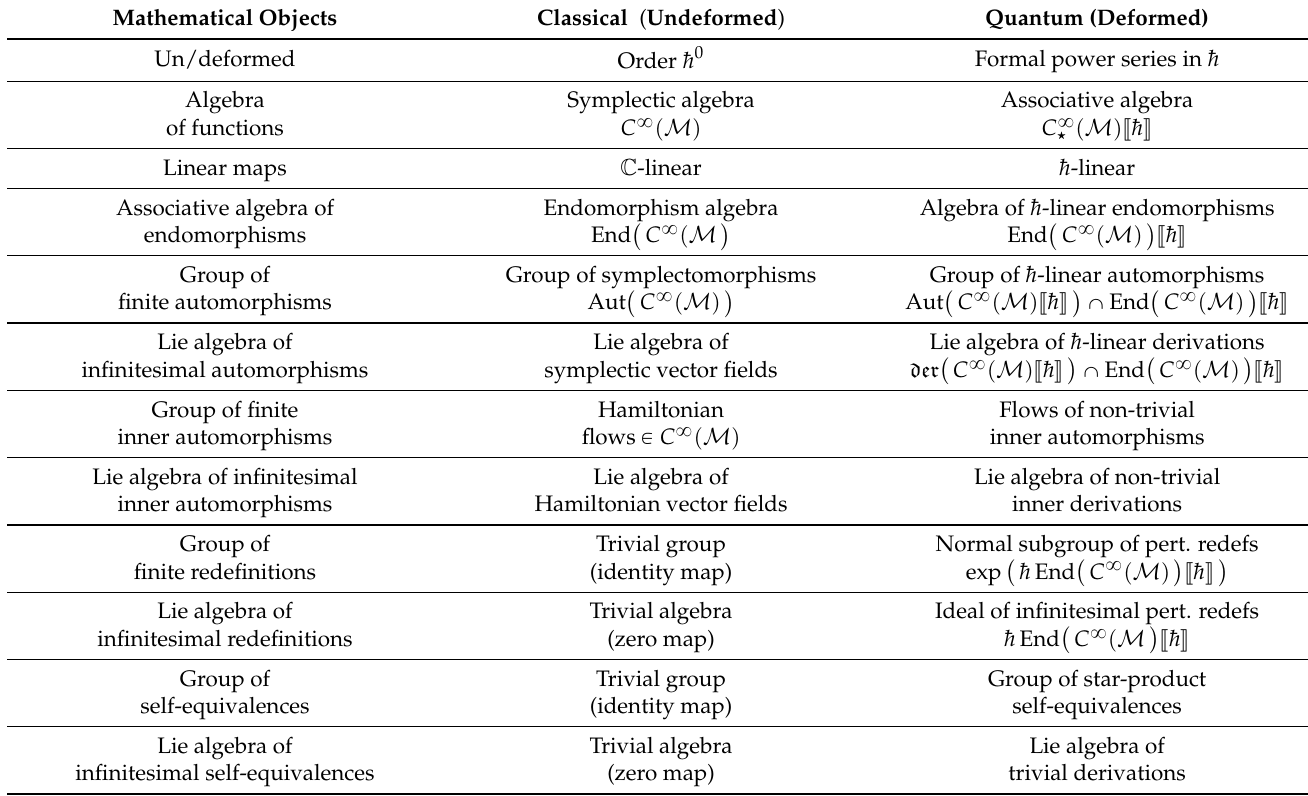
Table 3. Deformed vs. undeformed algebra of